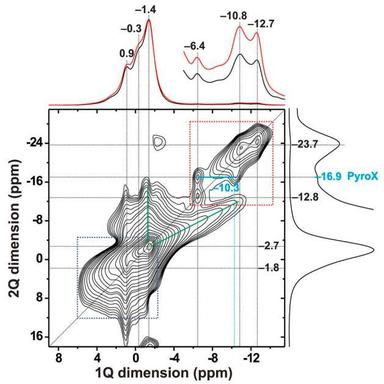
2Q–1Q correlation 31P NMR spectrum acquired from the MonA cement at 14.00 kHz MAS, with 2QC generated by applying the pulse sequence for 1.714 ms. The 2D NMR spectrum is shown together with projections along the horizontal 1Q (top) and vertical 2Q (right) dimension, whereas the red trace is the 1 H→31P CPMAS result obtained under otherwise identical conditions. The rectangular areas enclose 2D spectral regions involving 2Q correlations among 31P sites of HPO4–HPO4 (blue), and P2O7–P2O7 (red)